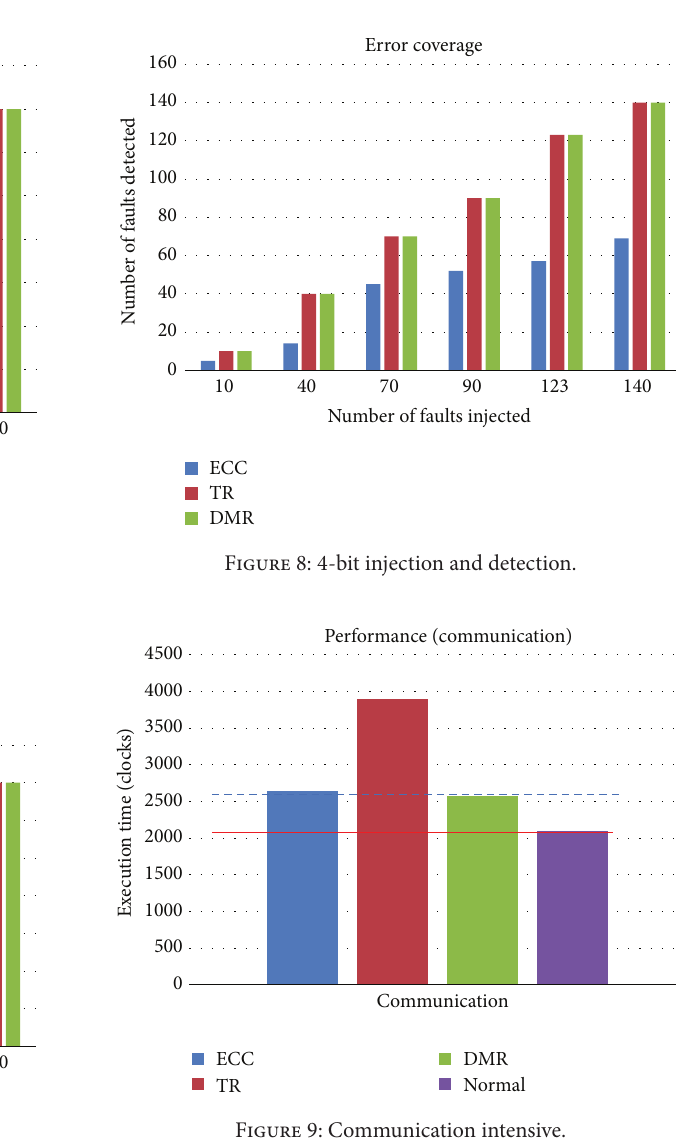
Figure 9: Communication